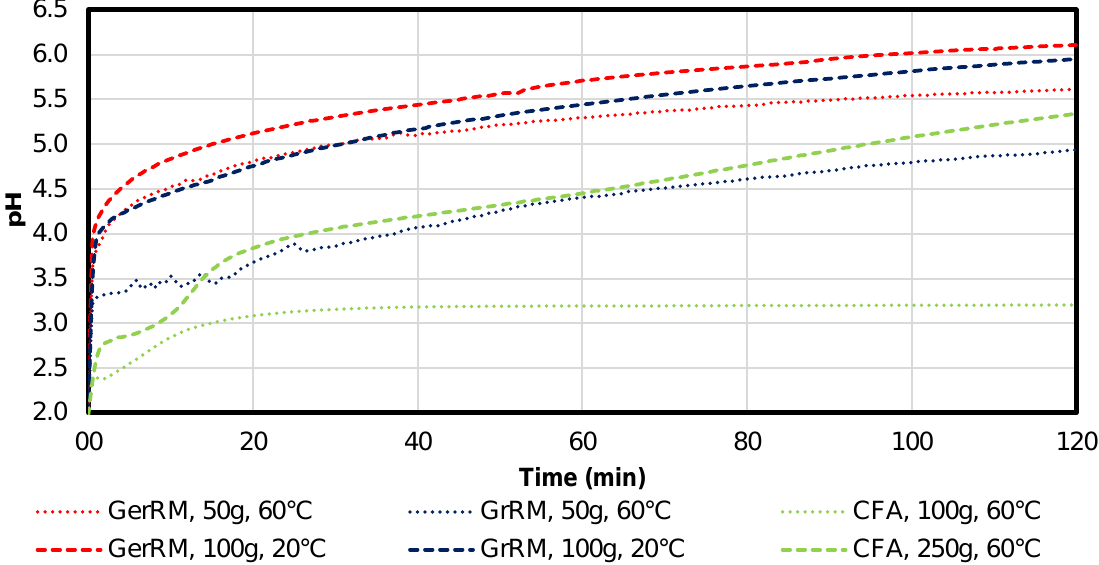
Figure 7. pH values in time (GerRM—German red mud; GrRM—Greek red mud; CFA—coal flying ash).